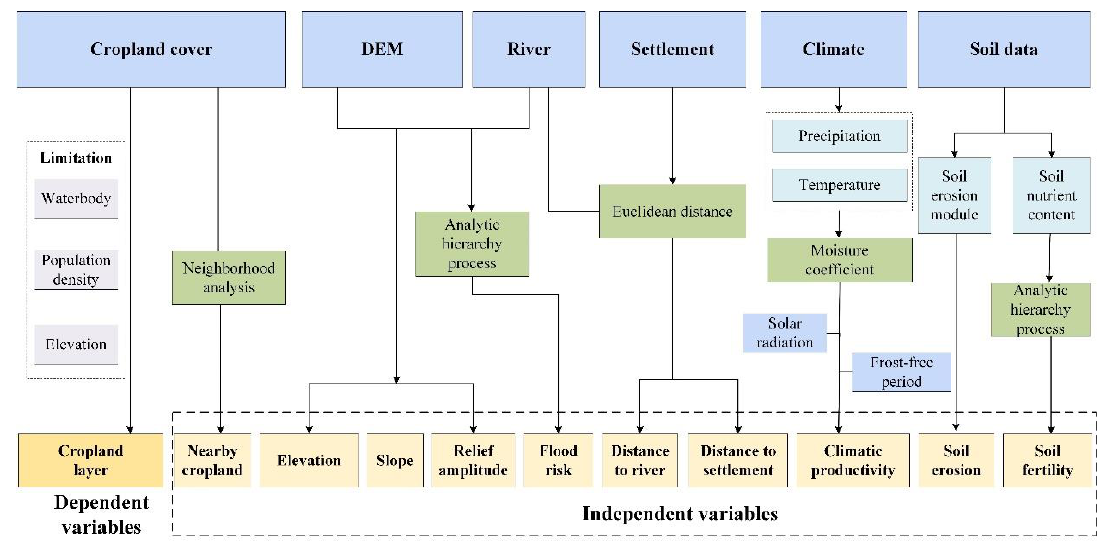
Figure 2. Flowchart of data preparation process.